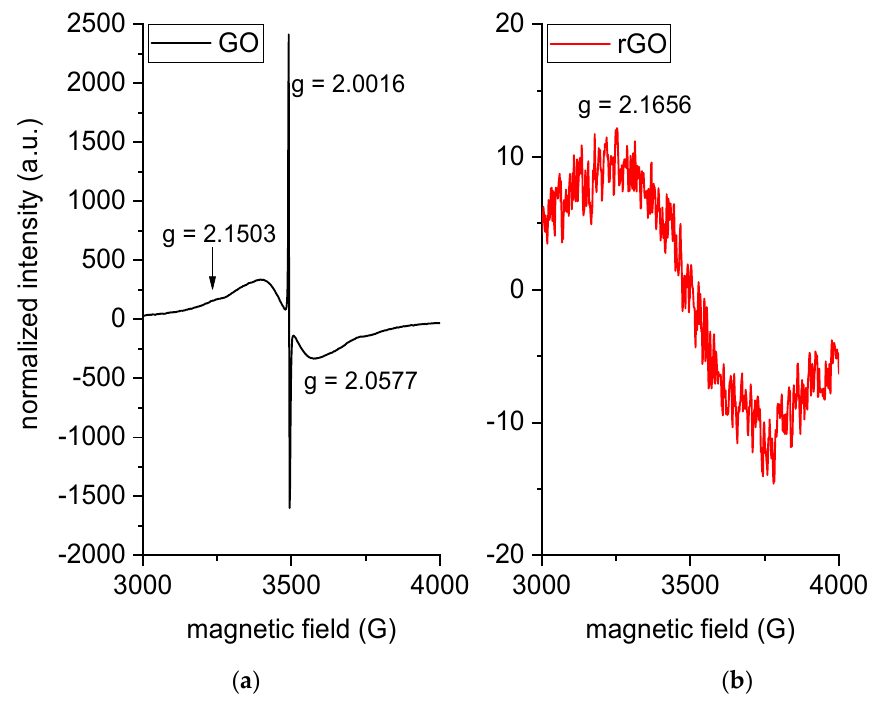
Figure 2. ESR spectra of GO ( a ) and rGO ( b